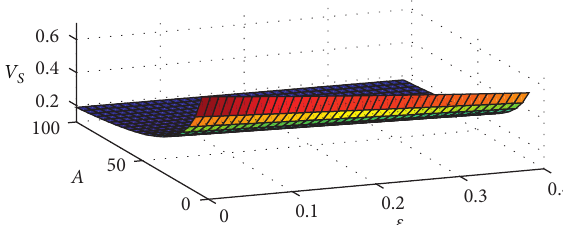
Figure 8: A plot of the smallest eigenvalue V radiation versus A and η for κ � 0 . 8, ε � 0 . 399, and n th � 0 . 15.